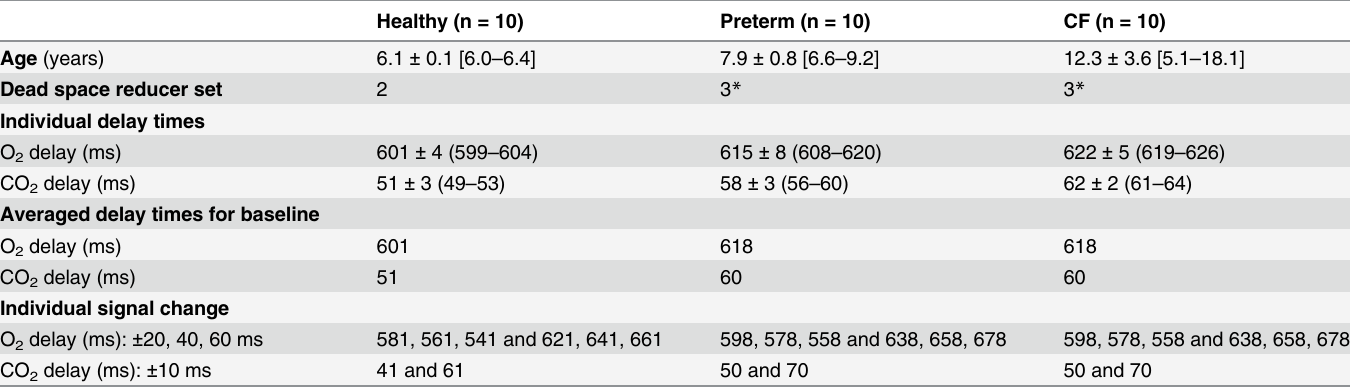
Table 1. Baseline settings per patient